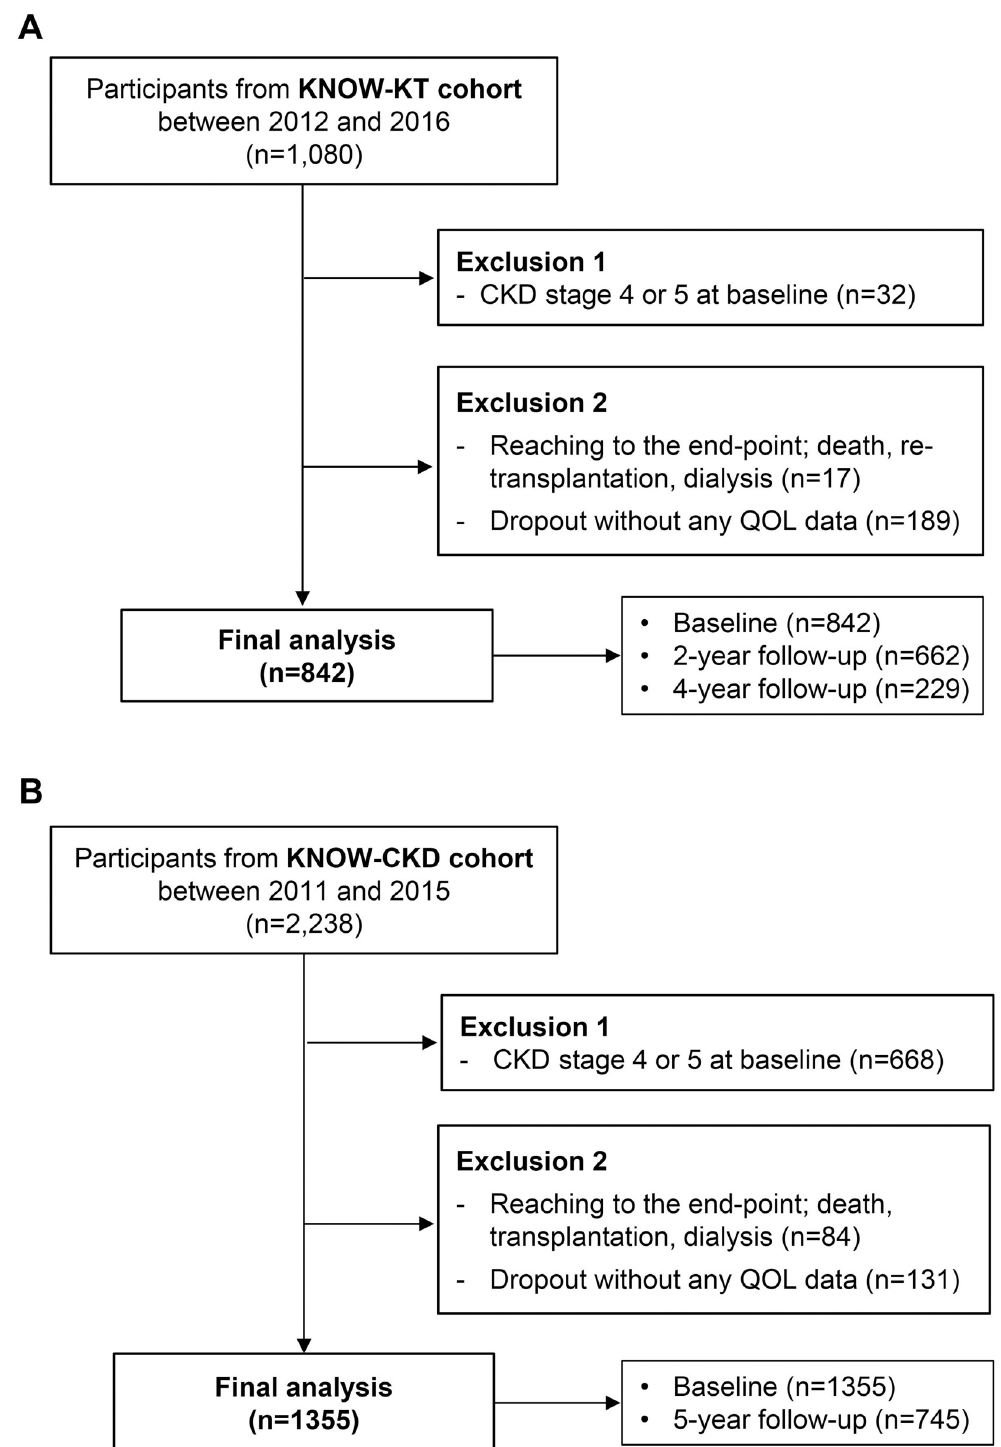
Fig 1. Flow diagram of the study population. (A) Among 1,080 KNOW-KT cohort participants, total 842 patients were analyzed after exclusion of 238 people. (B) Among 2,238 KNOW-CKD cohort participants, total 1,355 patients were analyzed after exclusion of 883 people. KNOW-KT, KoreaN cohort study for Outcome in patients With Kidney Transplantation; QOL, quality of life; KNOW-CKD, KoreaN cohort study for Outcome in patients With Chronic Kidney Disease.